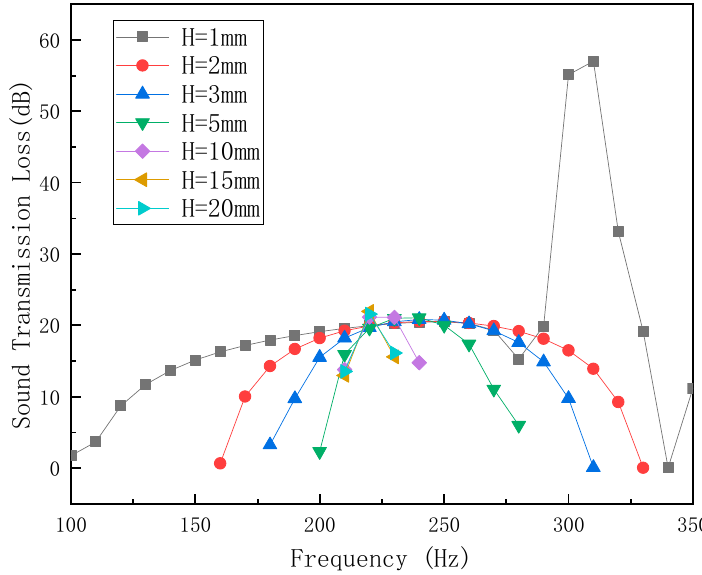
Figure 13. E ff ect of plate thickness on the cavity cave for cavity thickness of 10 Figure 13. Effect of plate thickness on the cavity cave for cavity thickness of 10 mm.